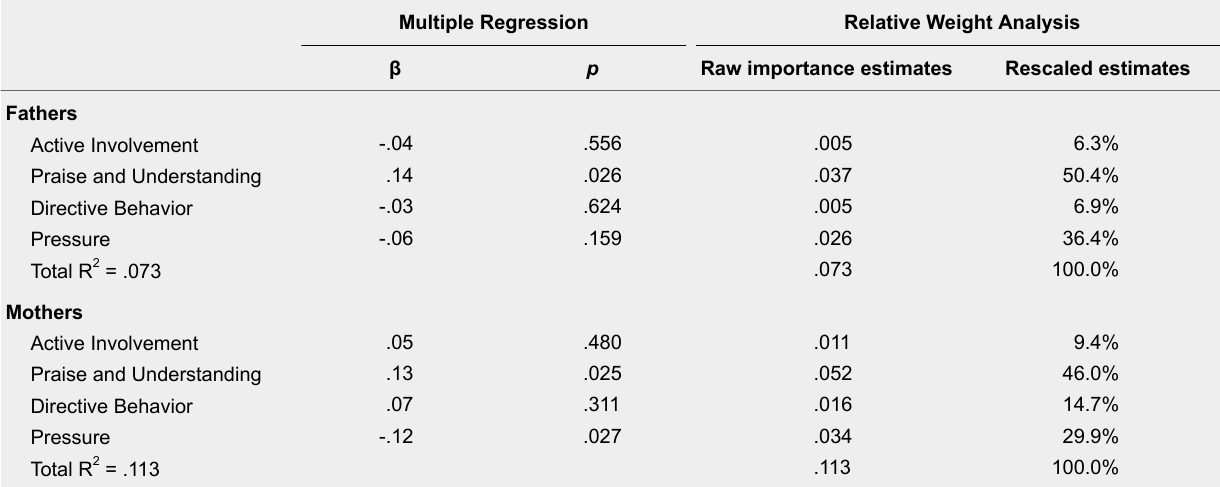
The Importance of Parental Involvement in Predicting Adolescents’ Sport Value Acceptance Multiple Regression Relative Weight Analysis β p Raw importance estimates Rescaled